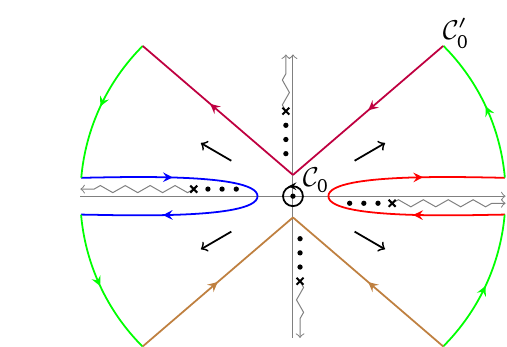
to C (cid:48) , which 0 0 , the purple contour 1